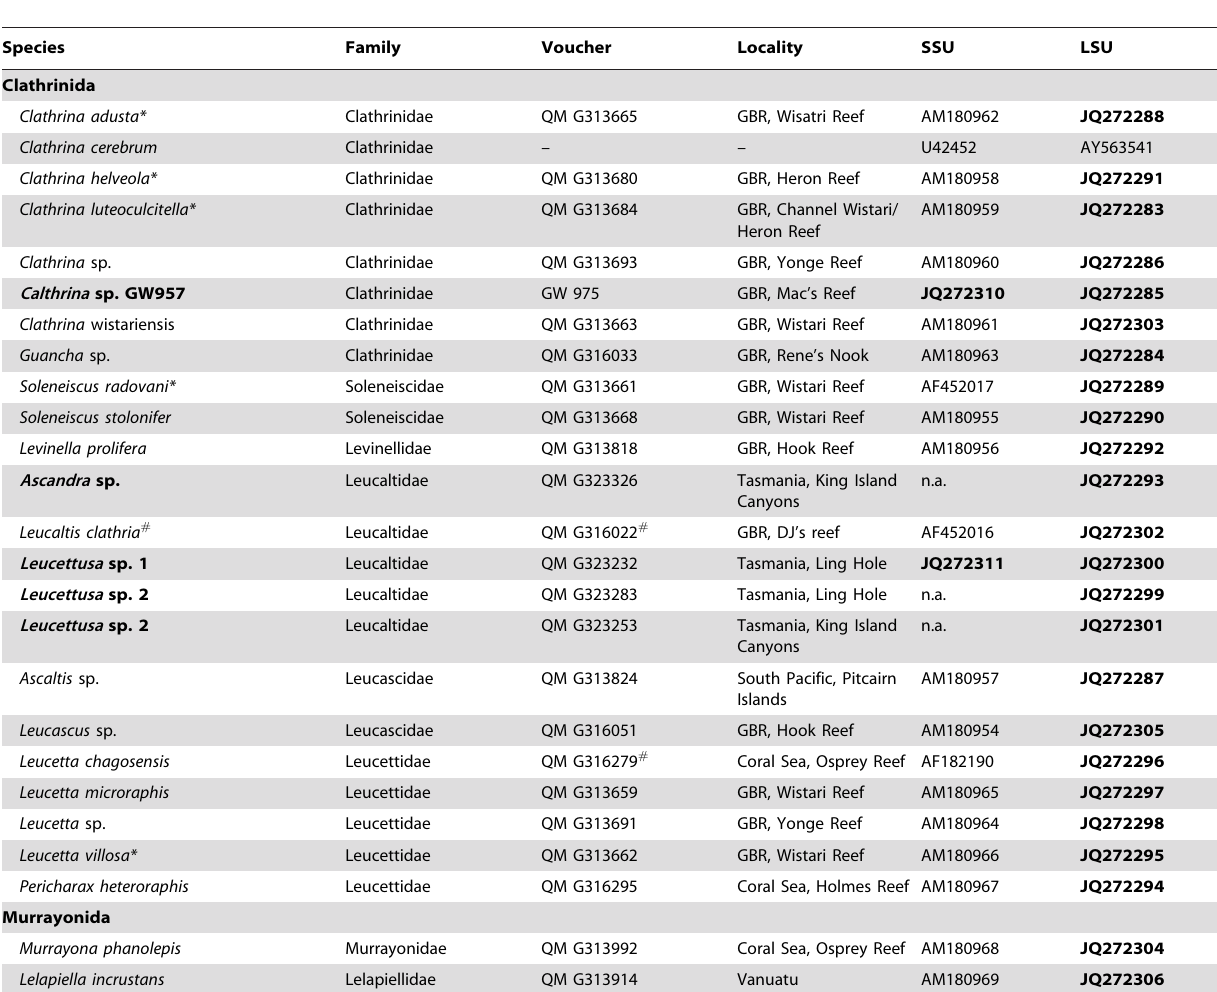
Table 1. Included specimens of Calcinea, their sample localities and GenBank accession